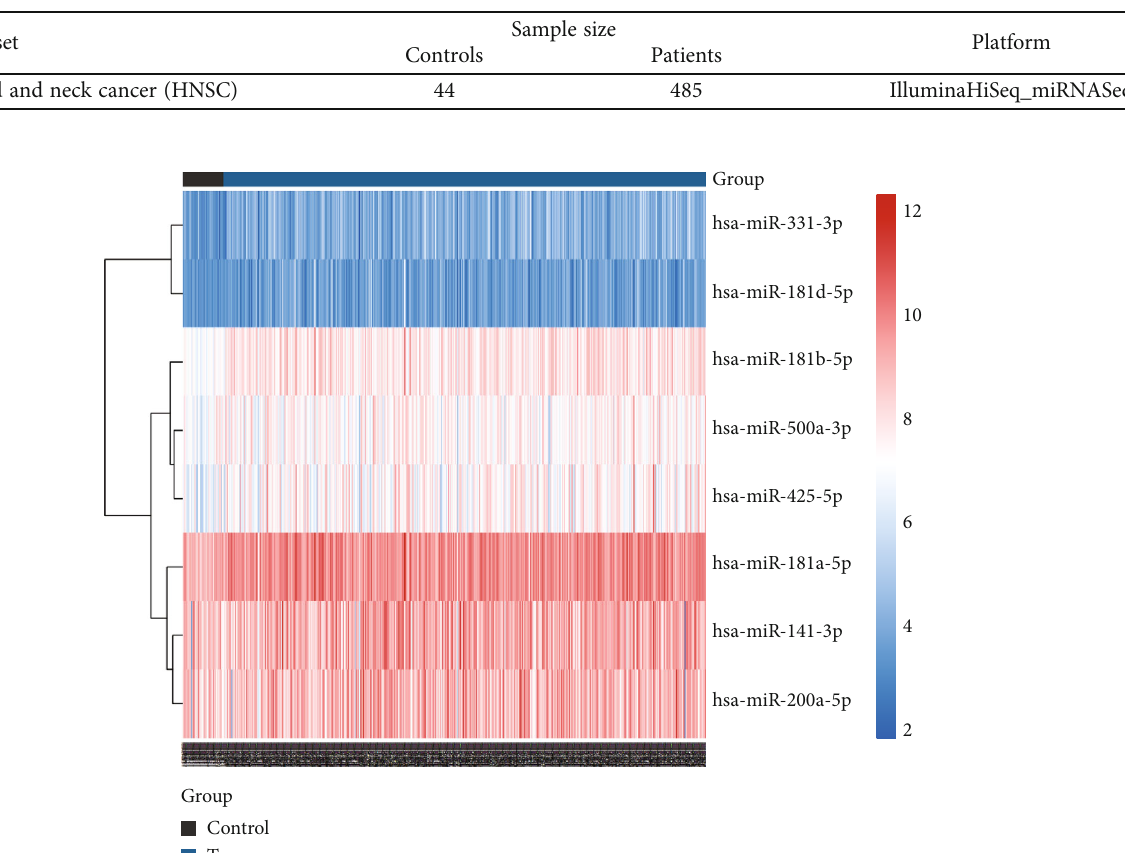
Table 1: Characteristics of dataset in this study.